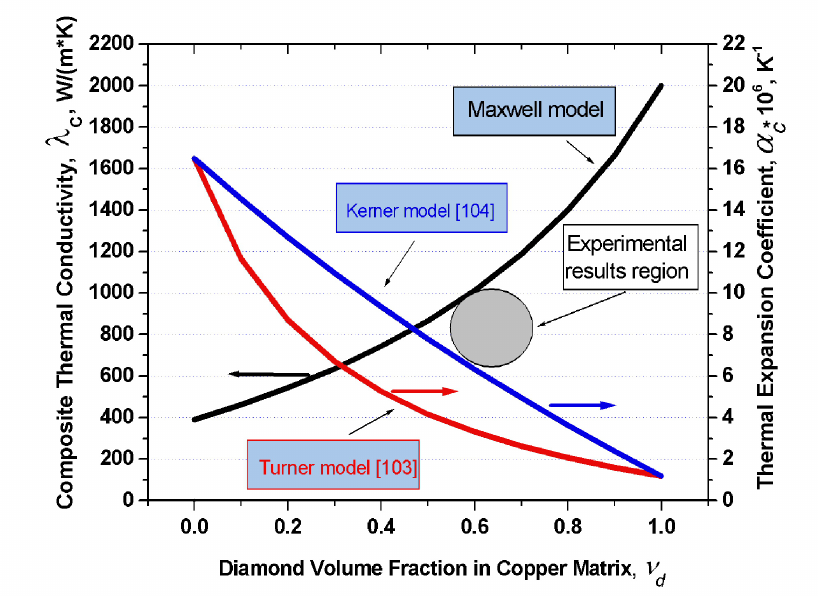
Figure 4. Graphs of the thermal conductivity in the diamond-copper system calculated in 16 the frame of the Maxwell model, and of the thermal expansion coefficient in terms of the 17 models of Turner and Kerner, plotted vs . composite composition. Grey circle indicates experimental values of the thermal conductivity and thermal expansion coefficient from